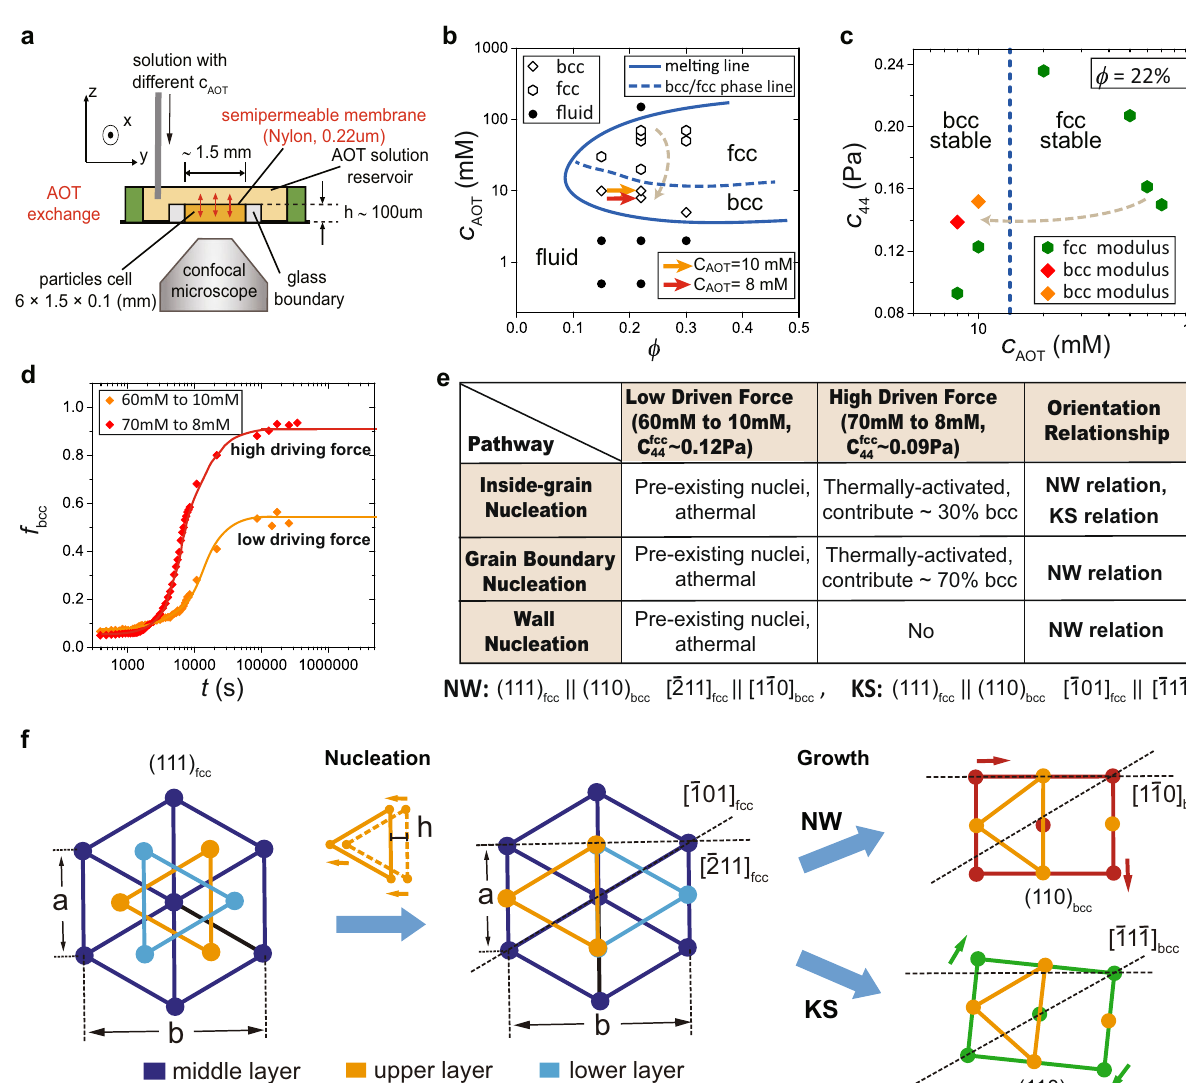
Fig. 1 Experiment details and softness-dependent pathways. a The side view of our experimental setup. The sample cell contains charged